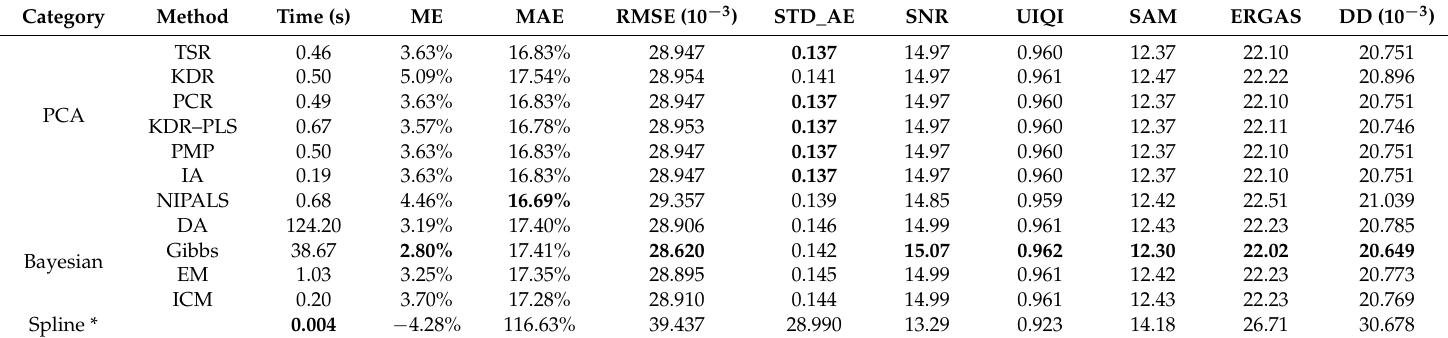
Table 2. Detailed comparison of fusion approaches implemented on the Site 1 data (tomato field).